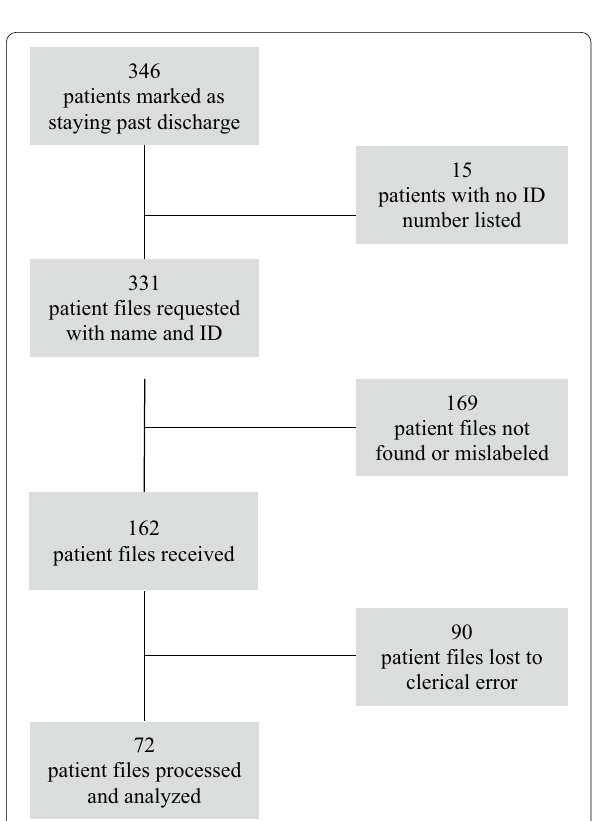
Fig. 1 Flow of medical records requested and